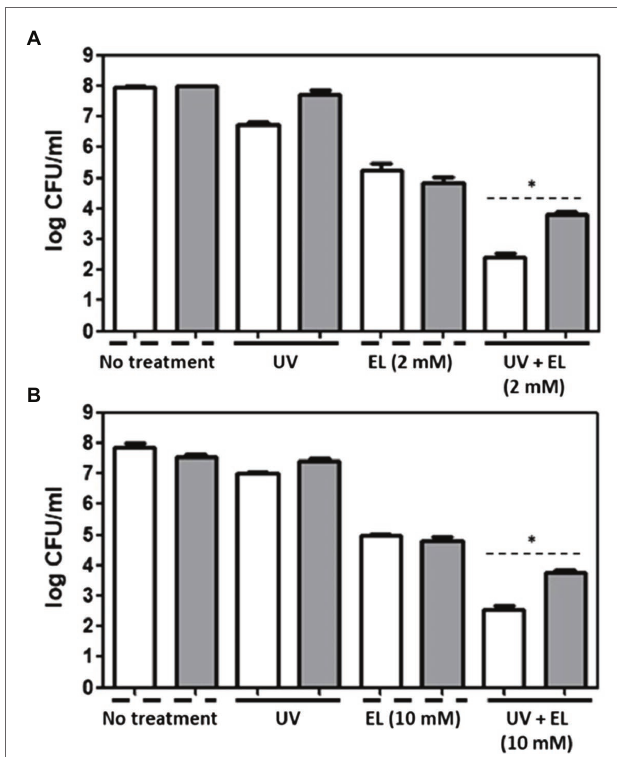
FIGURE 3 | Evaluation of antimicrobial effects of UVA and EL. UVA light-, EL-, and UVA/EL-treated (A) L. innocua and (B) E. coli O157:H7 cells in the presence of 100 mM thiourea (gray bar), respectively, compared with the negative control without antioxidant (white bar). The mean values from three independent measurements are shown. Asterisk ( * ) indicates significant difference between thiourea-untreted and -treated groups ( p ≤